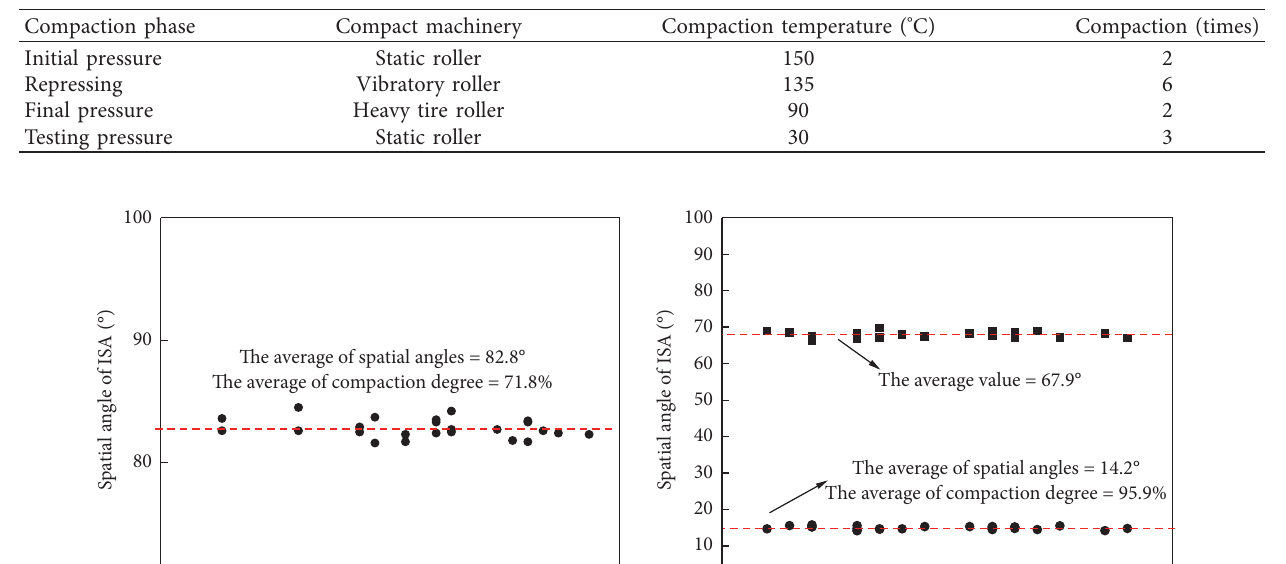
Table 8: The road compaction scheme.